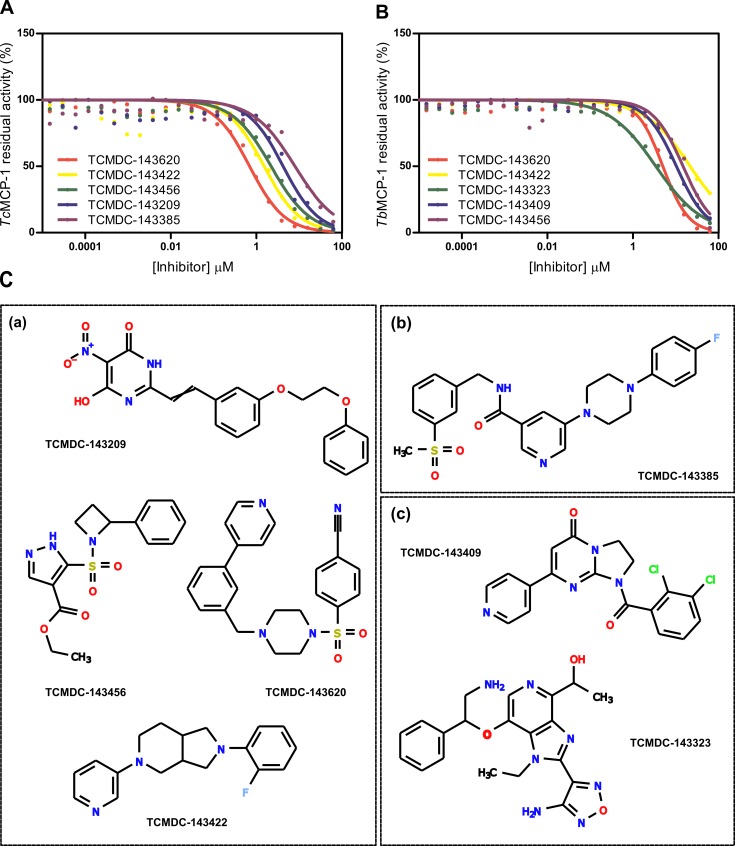
Dose-response curves and structures of top-five inhibitors identified for each MCPs.To estimate the potency of the inhibitory activity, enzymes were incubated with different concentrations (ranging from 7,5 pM to 62,5 μM) of the selected compounds and the inhibition percentages determined for each condition as indicated in Material and Methods. For each compound, solid line represents the best fit of four-parameter Hill equation to experimental data (closed circles). (A) Dose-response curves corresponding to the most potent TcMCP-1 inhibitors. (B) Equivalent analysis for the top-five TbMCP-1 inhibitors. (C) Structure and identifiers corresponding to the most potent hit compounds identified for both enzymes. Subgroup (a) contains those molecules that inhibited both MCPs. Subgroup (b) is formed by TCMDC-133485, which selectively acts on TcMCP-1 whereas subgroup (c) includes TbMCP-1 specific inhibitors.